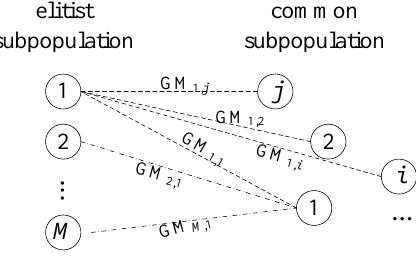
An Example of Gravitational